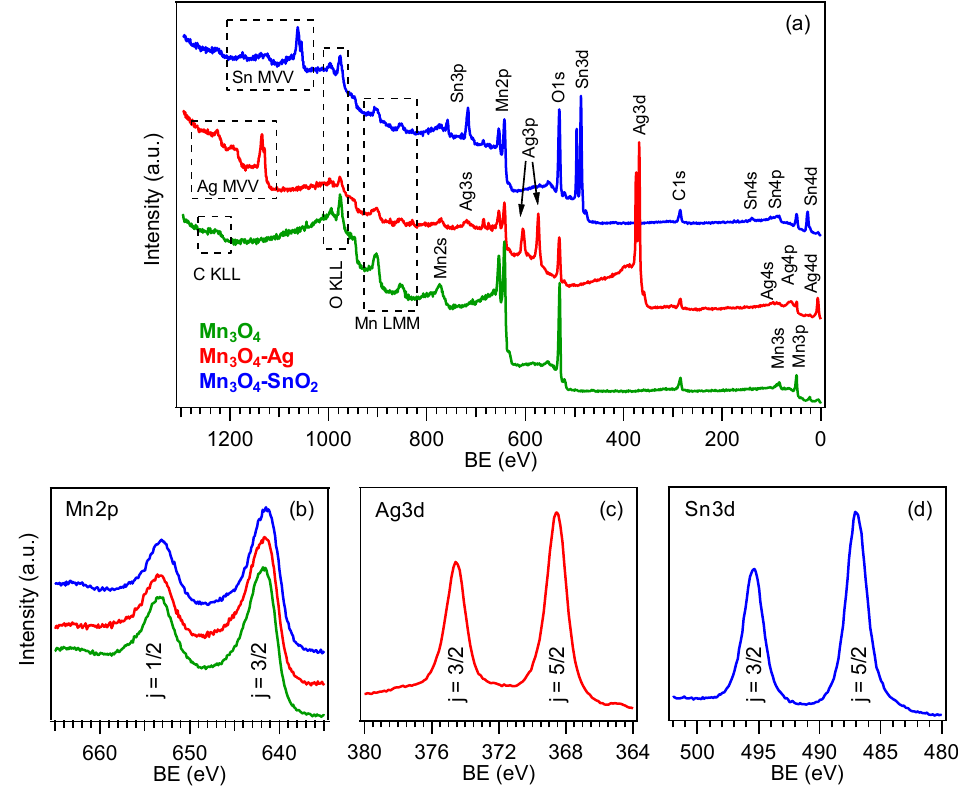
Figure 3. ( a ) X-ray photoelectron spectroscopy (XPS) wide-scan spectra pertaining to bare Mn 3 O 4 , Mn 3 O 4 -Ag and Mn 3 O 4 -SnO 2 samples. ( b ) Mn2p, ( c ) Ag3d and ( d ) Sn3d photoelectron peaks. The color code is reported in panel ( a